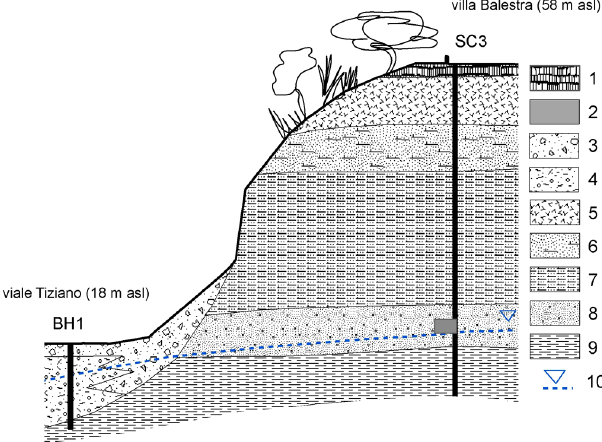
Fig. 6. Geological section. Legend: (1) human backfill and re- worked pyroclastics; (2) WWII air-raid shelter; (3) slope detritus (Holocene); (4) Tevere R. alluvial deposits (Holocene); (5) loose pyroclastics (Middle Pleitocene-Upper Pleistocene); (6) calcareous sand (Middle Pleistocene); (7) silty to sandy calcareous beds and phytoclastic travertine (Middle Pleistocene); (8) fine to medium sand and gravel alluvial deposits (Middle Pleistocene); (9) over- consolidated silt and silty clay (Lower Pliocene); (10) water table.